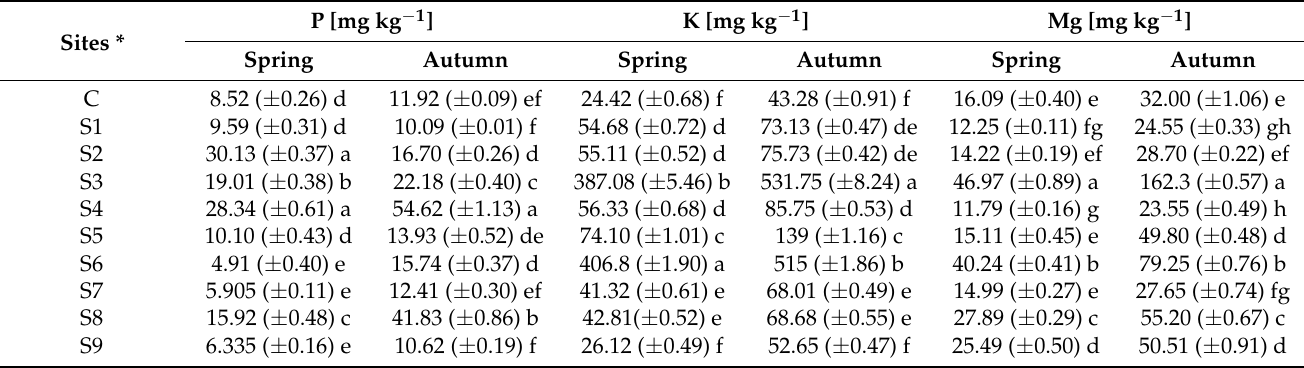
Table 2. Content of available phosphorus (P), potassium (K) and magnesium (Mg) in